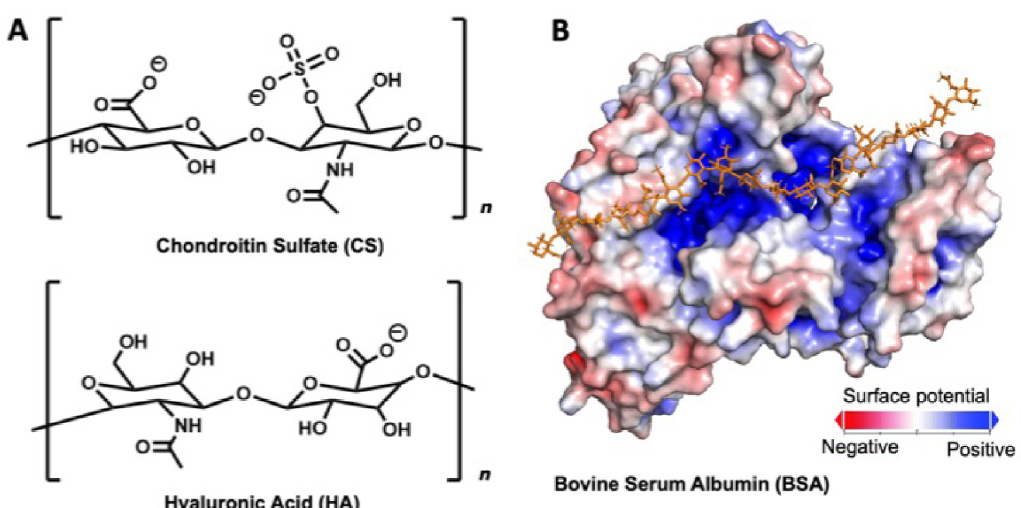
Figure 1. ( A ) Structures of chondroitin sulfate (CS) and hyaluronic acid (HA). ( B ) Relative surface charge densities of bovine serum albumin (BSA). BSA’s binding pocket is indicated with the example HA